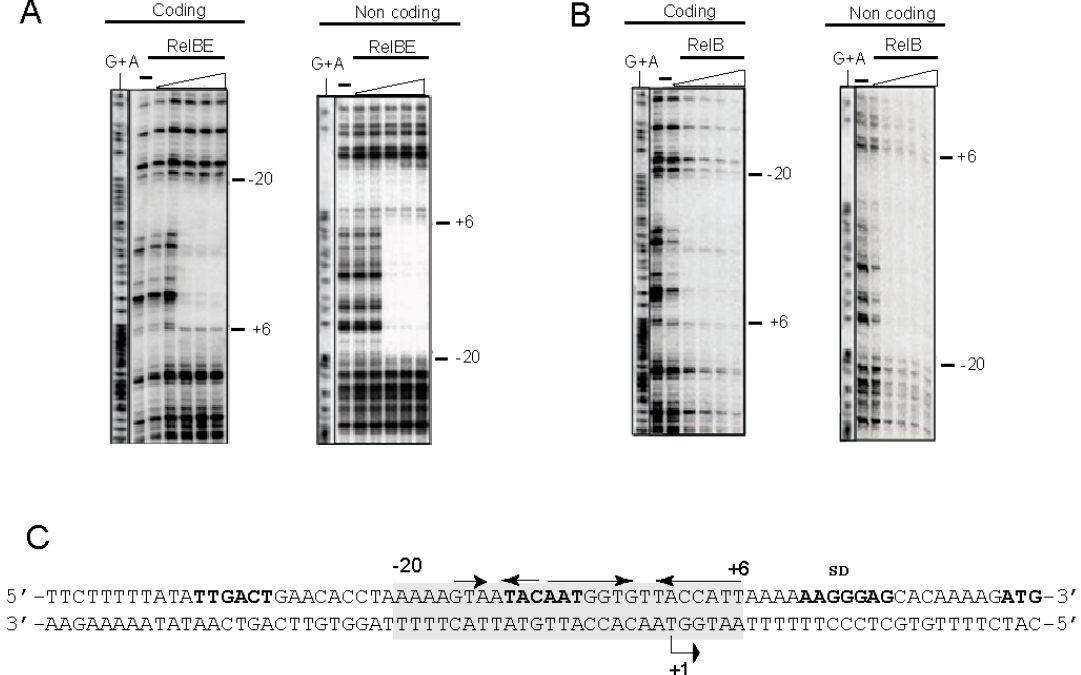
Figure 4. Binding of RelB and RelB:RelE to their DNA target assessed by footprinting with DNase I. DNase I footprints generated by RelB:RelE complex ( A ) and RelB protein ( B ) on the coding and non-coding strands of the labelled DNA fragment encompassing the P relBE promoter ( C , boldface letters). Concentrations of RelB used were of 5, 10, 15, 20, and 30 µM, whereas those of the RelB:relE complex were of 0.4, 0.8, 1.0, 2.0, and 5 µM. Reaction samples were run on 8% polyacrylamide gels, where ( − ) indicate the controls completed in the absence of the proteins; G+A are the sequencing reactions performed on the same DNA fragment labelled at the coding and non-coding strands. ( C ) Shows a schematic representation of the DNase I footprints (shadowed, from positions − 20 to +6 respective of the transcription start point, +1) on the promoter DNA sequence relative to the position of the two palindromic sequences (arrows with arrowheads pointing to the symmetry axis). − 35 and − 10 boxes, transcription initiation point (+1), SD sequence and initiation codon of RelB are shown in boldface